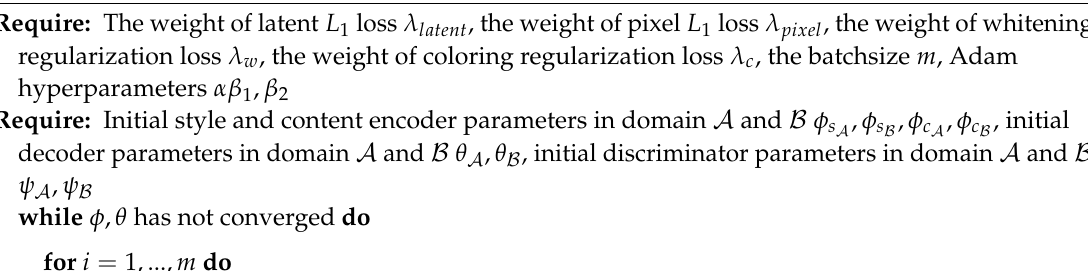
Algorithm 1 Unsupervised Virtual Try-on